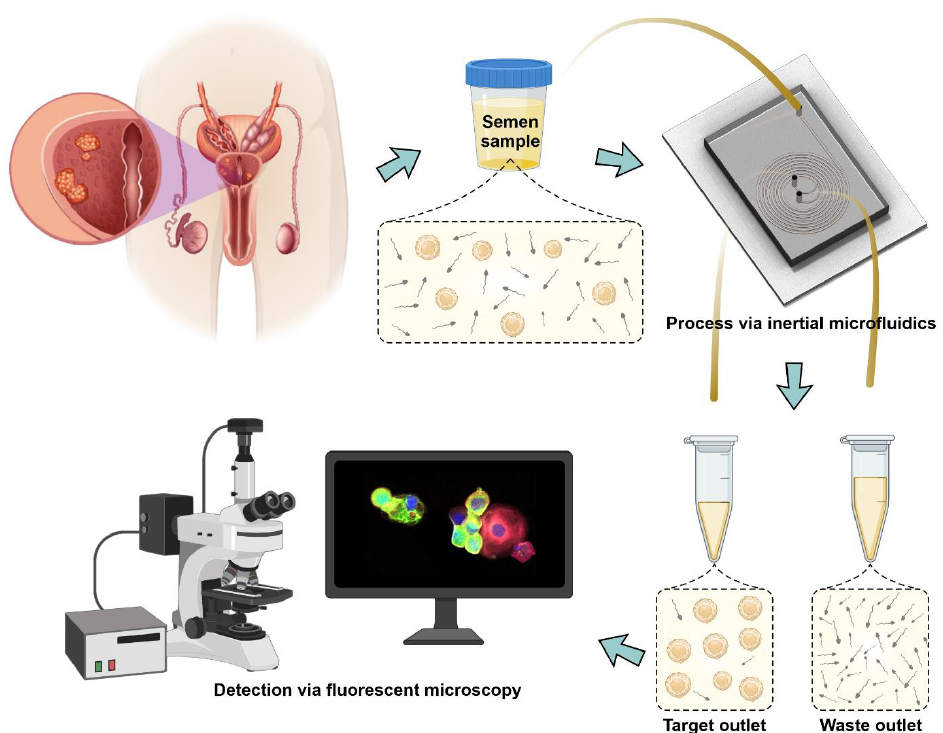
Figure 1. Schematic illustration of the technique for microfluidic isolation of CTCs from SF, with further detection of the isolated CTCs.